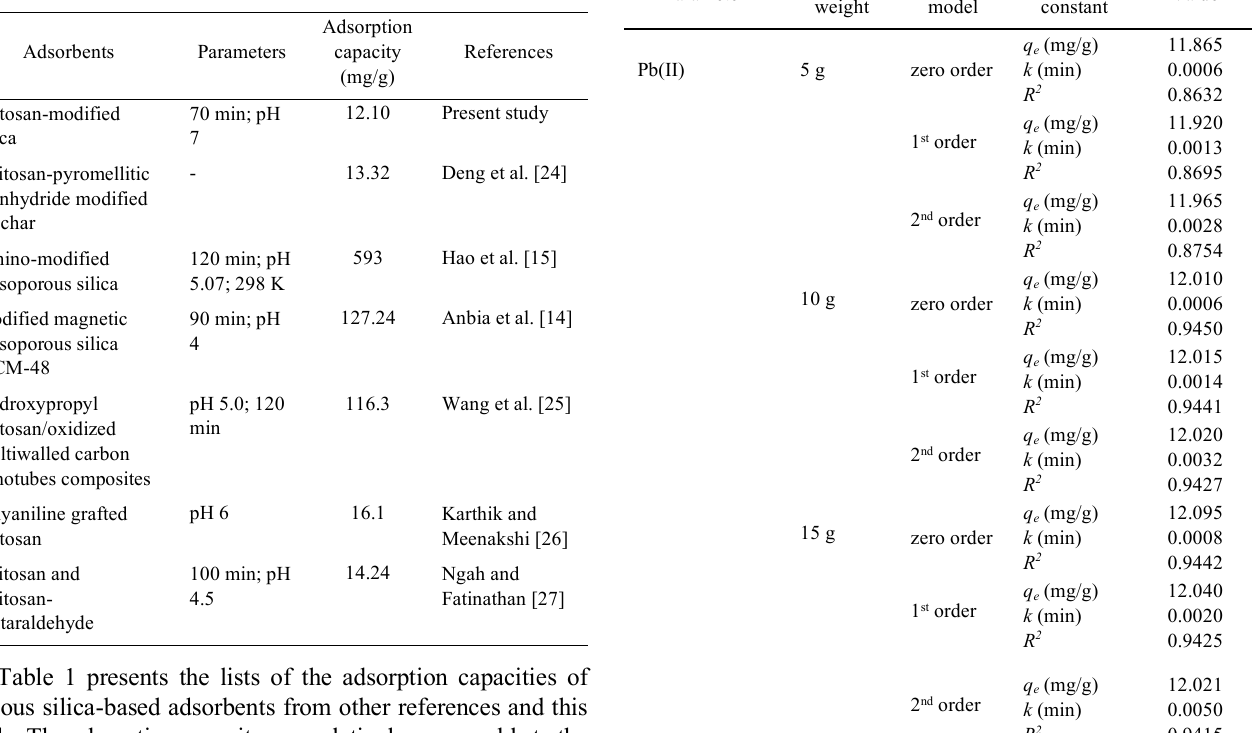
Fig. 4. Effect of Si-Kit adsorbent weights on colour adsorption Table 1. Adsorption capacities of silica-based, chitosan based, modified- silica, modified-chitosan adsorbents for Pb (II) ions sorption